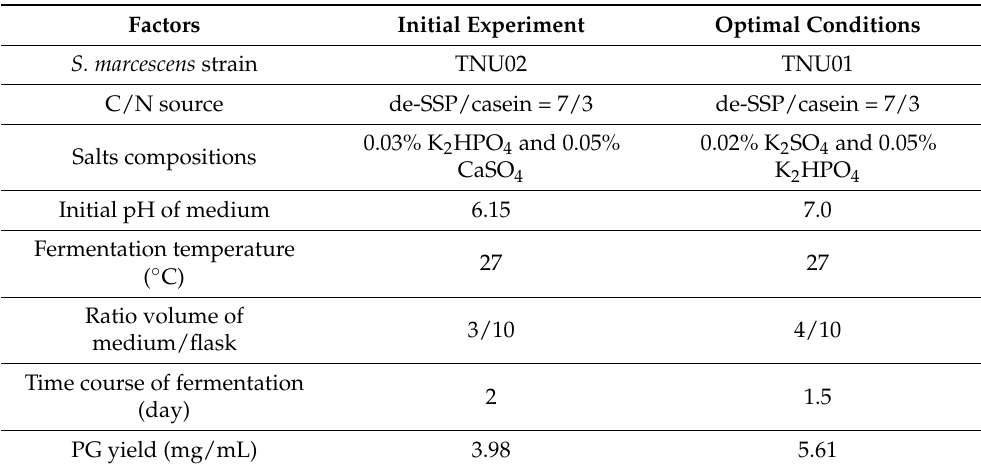
Table 2. The fermentation conditions and PG yield before and after